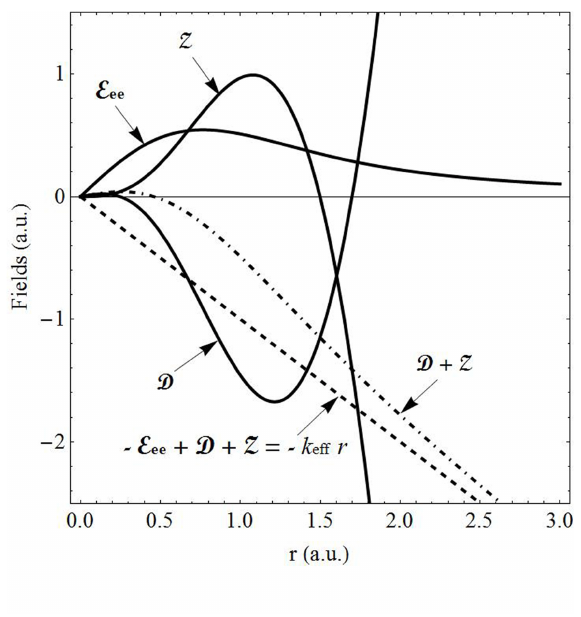
Figure 2. The electron-interaction E ee ( r ) , kinetic Z ( r ) , and differential density D ( r ) components of the internal field F int ( r ) for a quantum dot in a magnetic field in its ground state. The sums D ( r ) + Z ( r ) ,